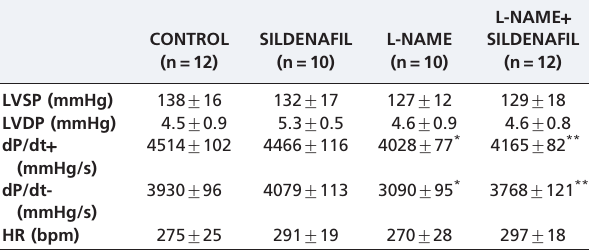
Table 1 - Isolated heart (Langendorff technique). Development of left ventricular systolic (LVSP, mmHg) and diastolic (LVDP, mmHg) pressures, first temporal derivative of LVDP positive development (dP/dt + , mmHg/s), first temporal derivative of the LVDP negative pressure (dP/dt-, mmHg/s) and heart rate (HR,